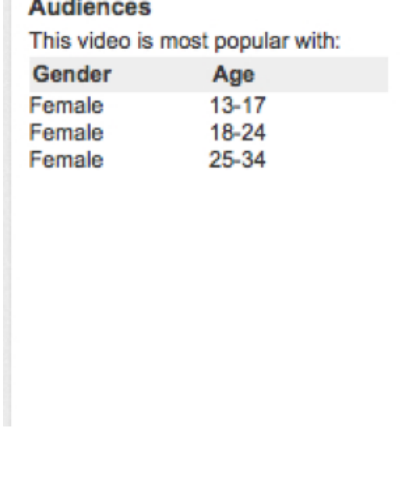
Figure 6. Demographics of the pro-anorexic video “Princesas de Porcelana”